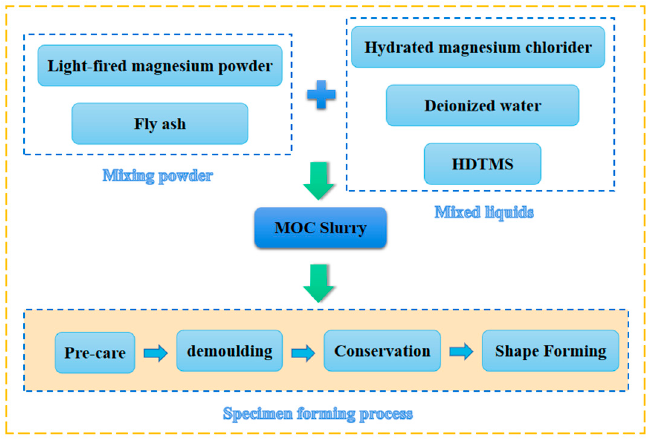
Figure 1. Flow chart for preparation of MOC specimens.